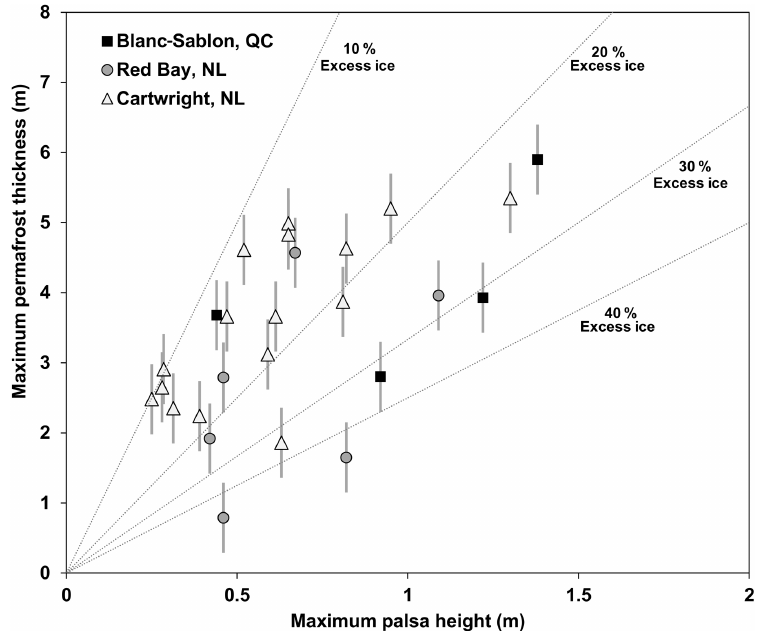
Figure 10. Comparison between maximum mound height and inferred maximum permafrost thickness. Dotted lines depict the association for excess ice quantities of 10%, 20%, 30%, and